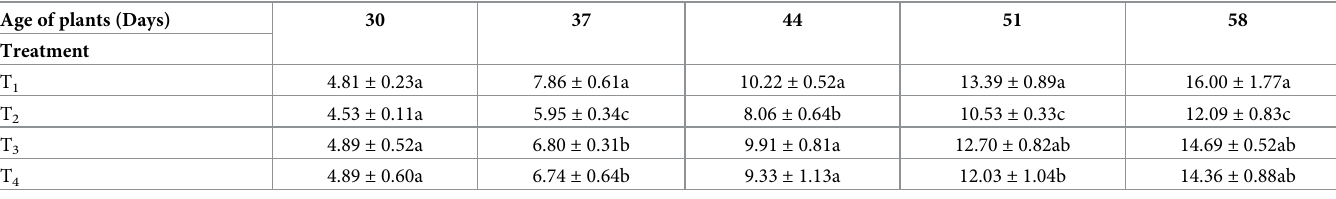
The data shown are the mean values of 4 replicates of planting pots per treatment (each planting pot contained 9 plants). Different letters indicate significant differences at P < 0.05, using LSD’s Multiple Range